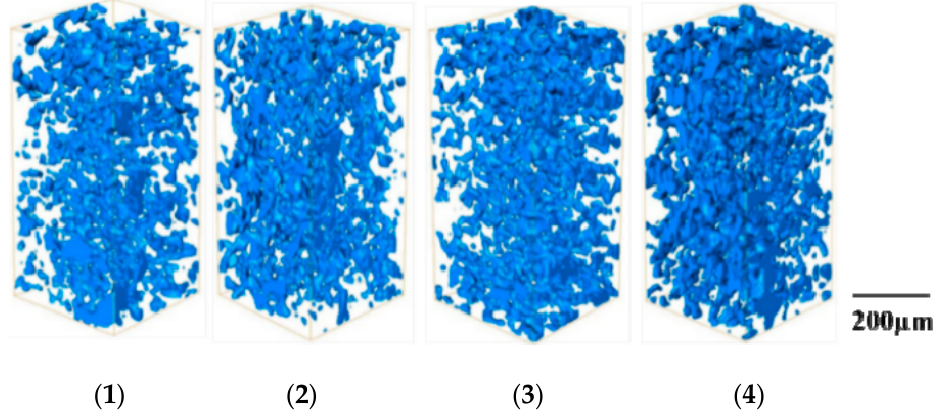
Figure 15. Fine pore structure at different heights within sheared samples (0.5 mm thick pore distribution). ( 1 ) 2 cm high; ( 2 ) 4 cm high; ( 3 ) 6 cm high; ( 4 ) 8 cm high.